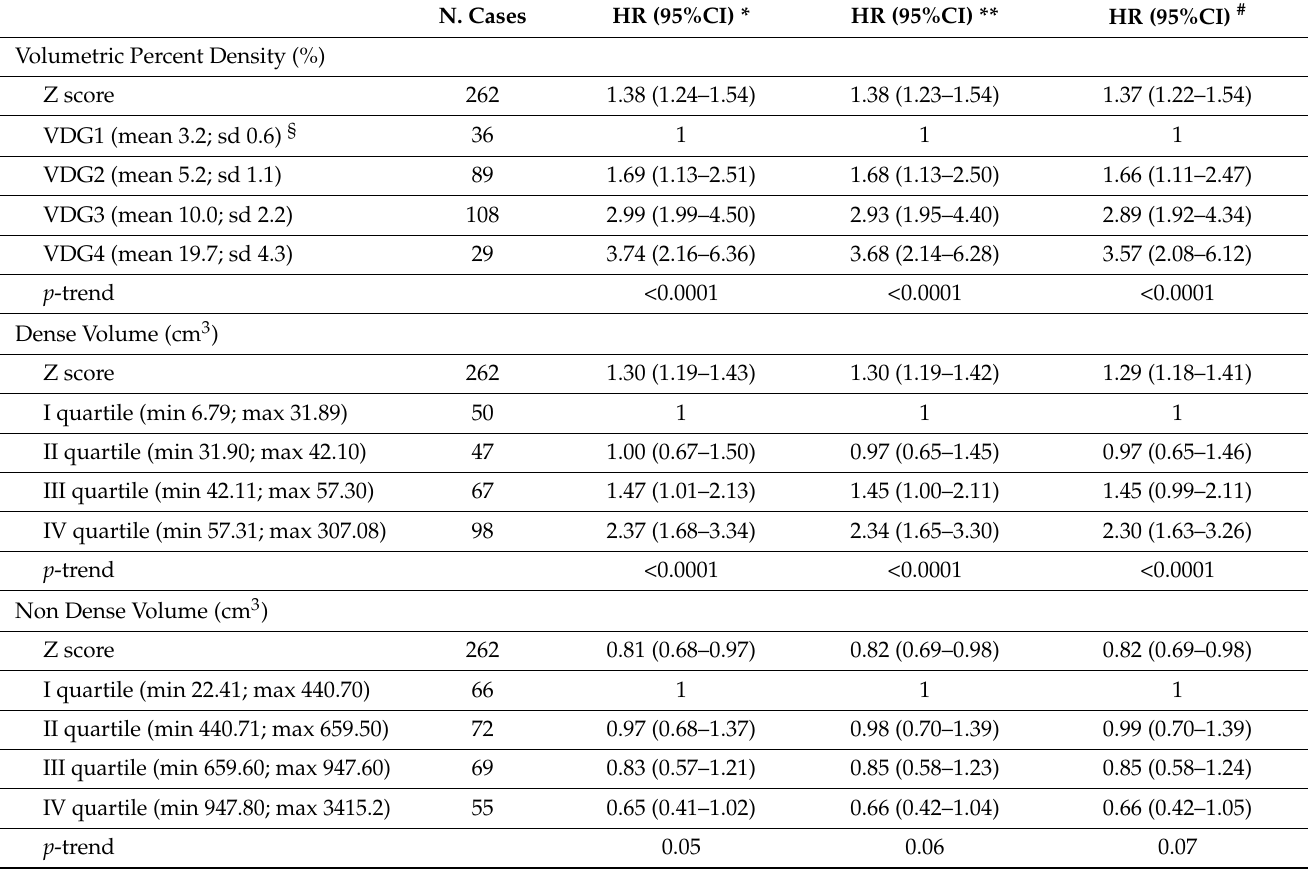
Table 2. Hazard ratios (HRs) and 95% confidence intervals (CI) of breast cancer risk in relation to mammographic density measures in the 6148 FEDRA study women. Results from Cox propor- tional hazards models with repeated mammographic density measures modeled as time-dependent covariates (18,939 total observations: 262 from breast cancer cases and 18,677 from 5886 non-cases). N. Cases